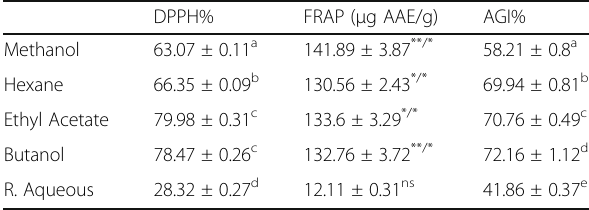
Table 2 DPPH scavenging activity, ferric reducing